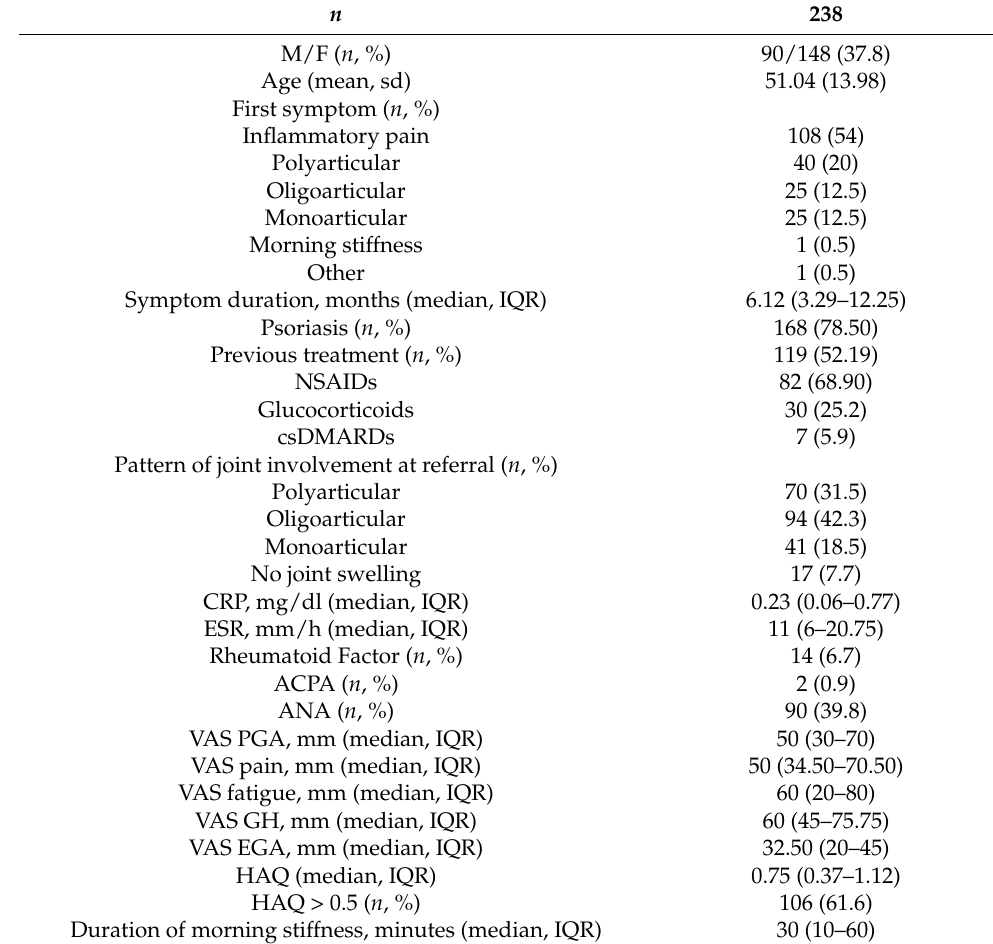
Table 1. Baseline characteristics of the included